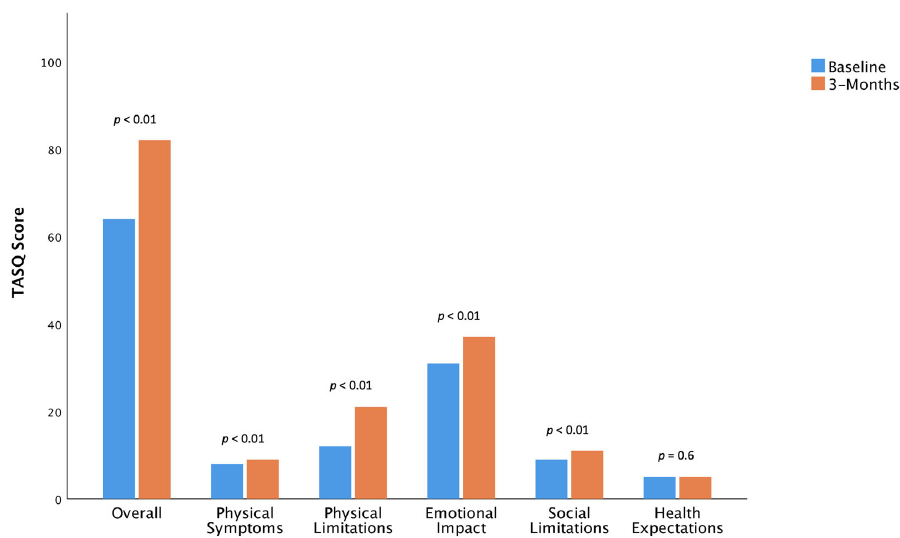
Figure 2. Absolute modification of TASQ score in non ‐ sarcopenic patients at 3 ‐ month follow ‐ up compared with baseline.